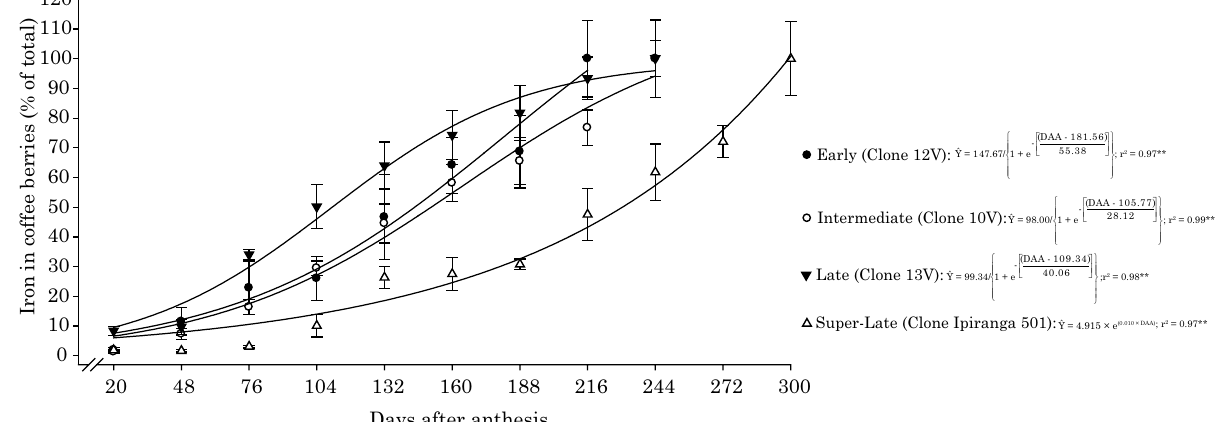
figure 1. Iron accumulation in berries (as a percentage of total accumulation) of four genotypes (clones) of ‘conilon’ coffee, from anthesis to fruit maturation. Bars represent standard deviation of the mean. **: significant at 1